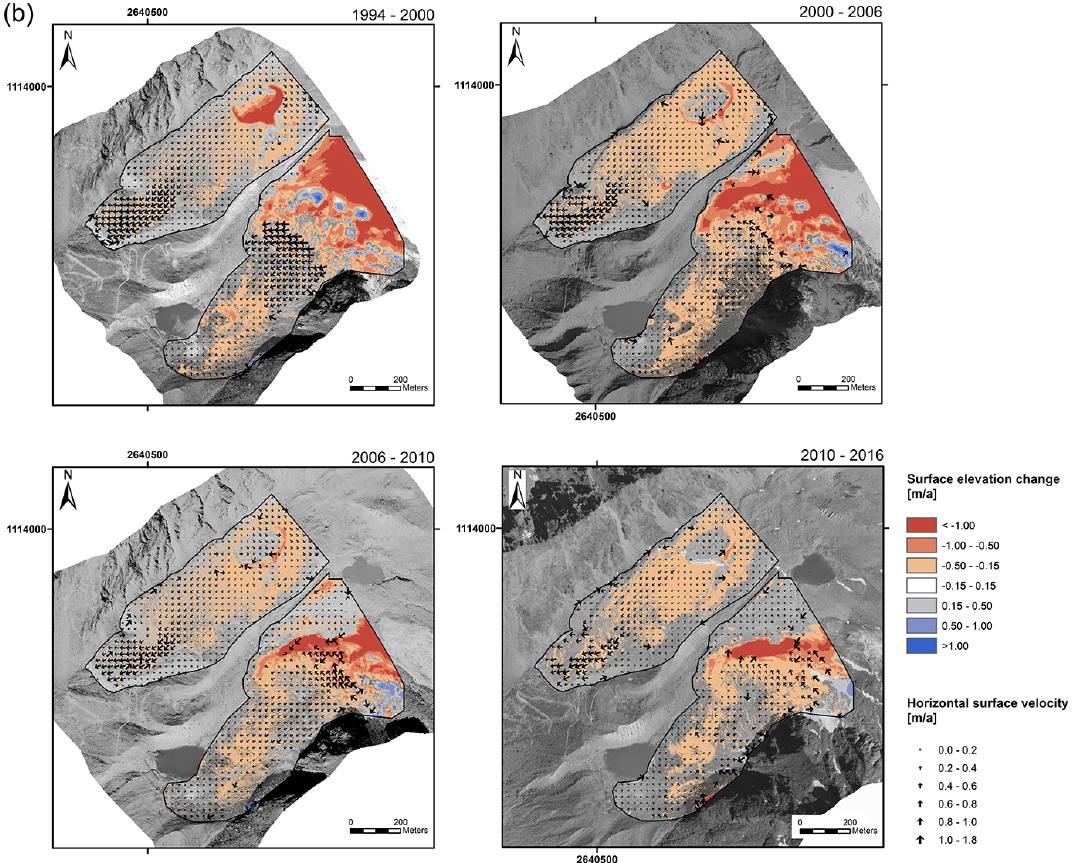
Figure 5. Overlay of the horizontal surface velocities (vectors) and the colour-coded changes in surface elevation (a) for the years 1970 to 1975, 1975 to 1979, 1979 to 1985, 1985 to 1991, and 1991 to 1995 for the rock glacier only (from Kääb et al., 1997) and (b) for the years 1994 to 2000, 2000 to 2006, 2006 to 2010, and 2010 to 2016 for the rock glacier and the debris-covered glacier tongue (for each observation period the later orthophoto is used as background: 2000, 2006, 2010, and 2016, respectively). Axes are labelled with Swiss coordinates (in metres; CH